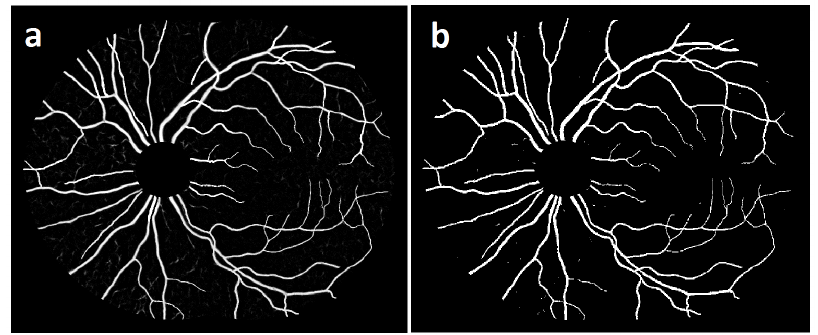
Figure 3. Image example: a) Vessel probability image b) Binary image.